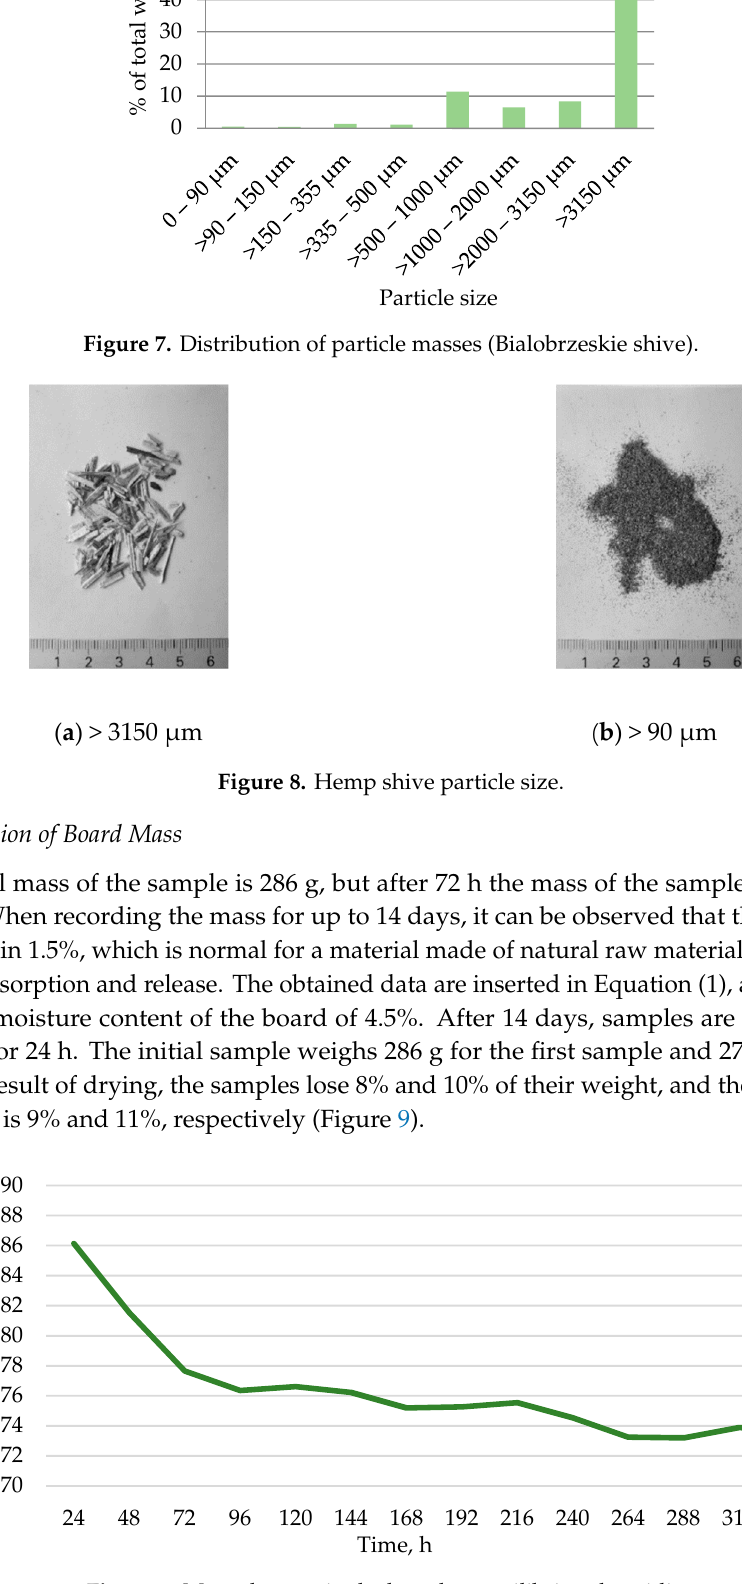
Figure 9. Mass changes in the board to equilibrium humidity.